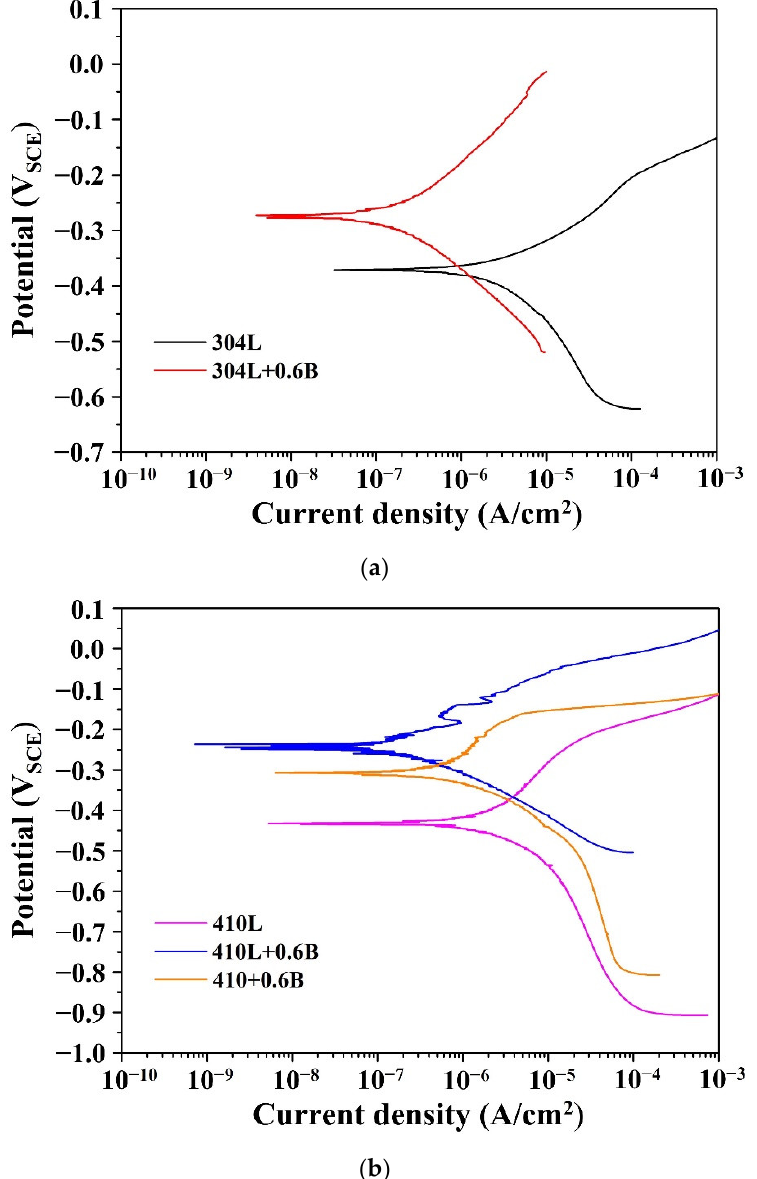
Figure 9. The polarization curves of PM stainless steels with and without B addition. ( a ) 304L and 304L + 0.6B ( b ) 410L, 410L + 0.6B, and 410 + 0.6B.